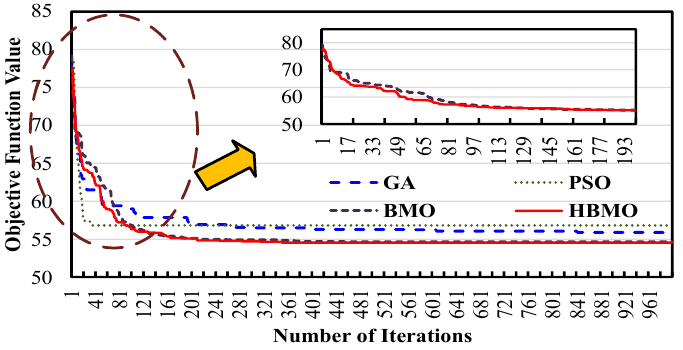
Figure 7. Comparison of convergence characteristics among methods.